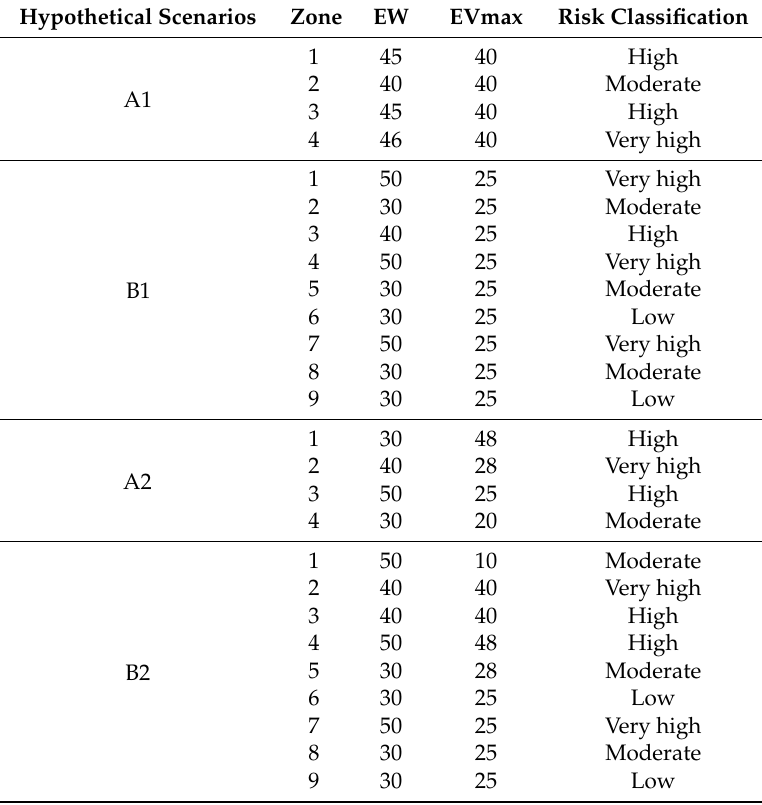
areas with high dengue incidence.